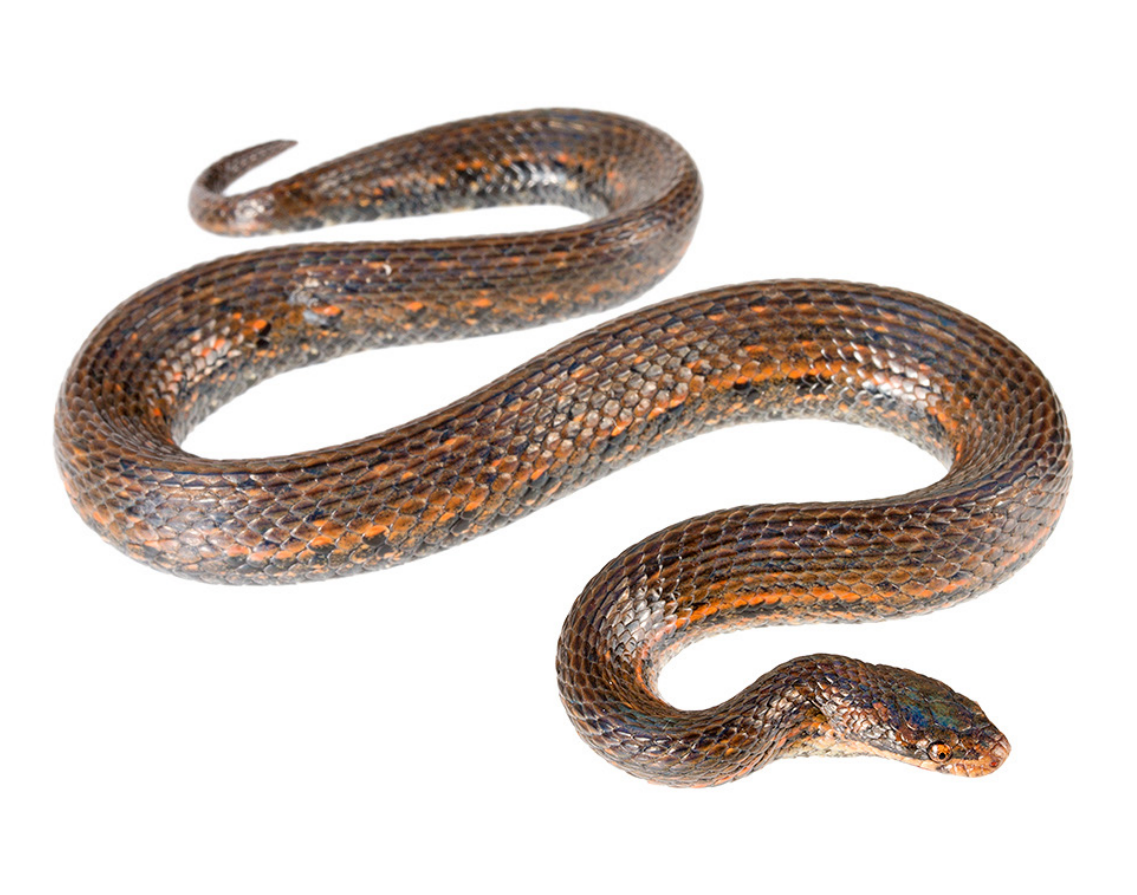
Fig. 14. Dorsal view of Tropidophis taczanowskyi (Steindachner, 1880) from Ecuador. Notice its conspicuously keeled dorsal scales and dorsolateral stripes. Photograph credit: Alejandro